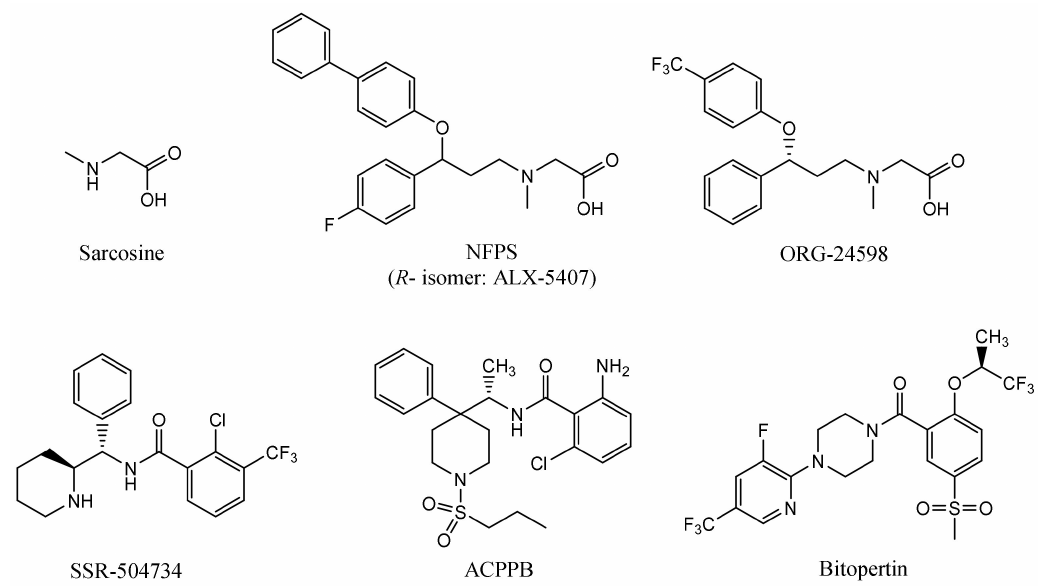
Figure 1. Examples of selective GlyT-1 inhibitors.